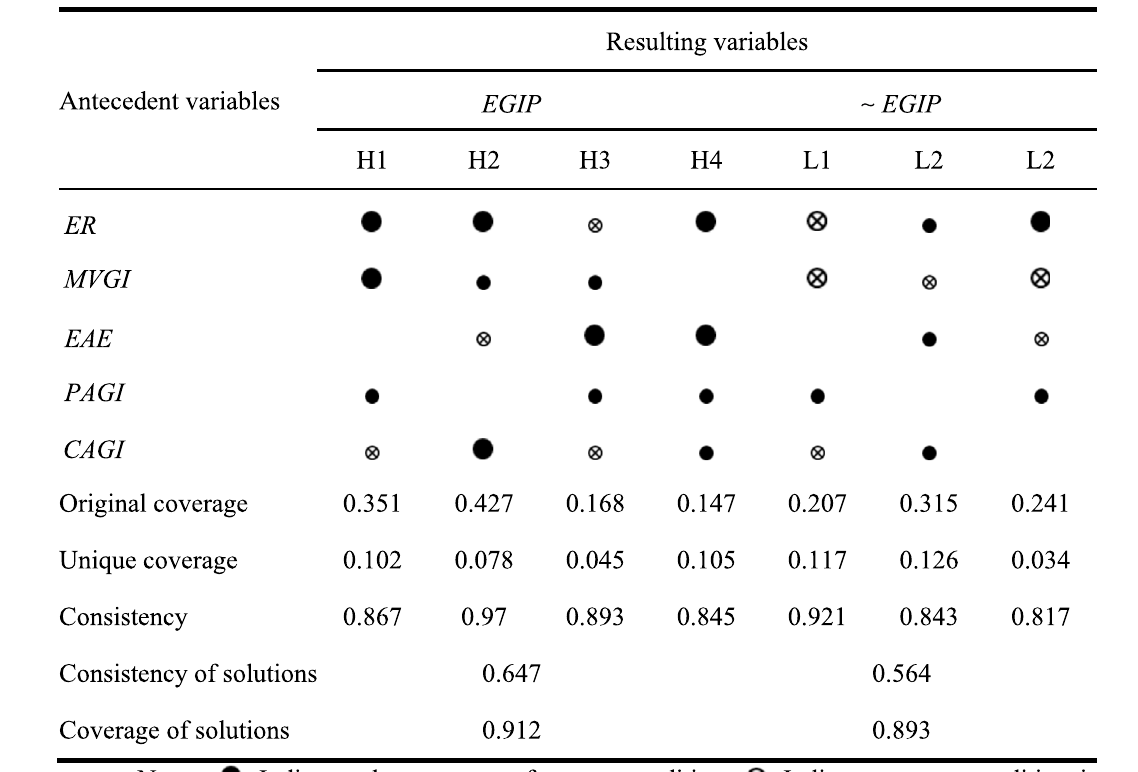
TABLE 6 Green innovation grouping of enterprises after adjusting the consistency threshold to